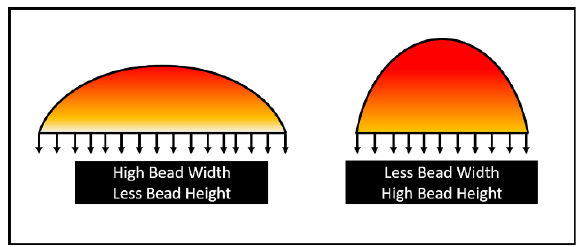
Figure 11. The schematic representation of the welding bead with the extent of conduction.